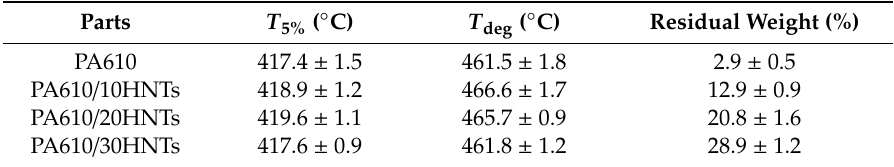
Figure 4. ( a ) Thermogravimetric analysis (TGA) curves and ( b ) first derivative (DTG) of polyamide 610 (PA610) composites with different HNTs loadings. Table 4. Main thermal degradation parameters of polyamide 610 (PA610) composites with different HNTs loadings of in terms of: temperature at a mass loss of 5 wt% ( T 5% ), maximum degradation rate temperature ( T deg ), and residual mass at 700 °C.